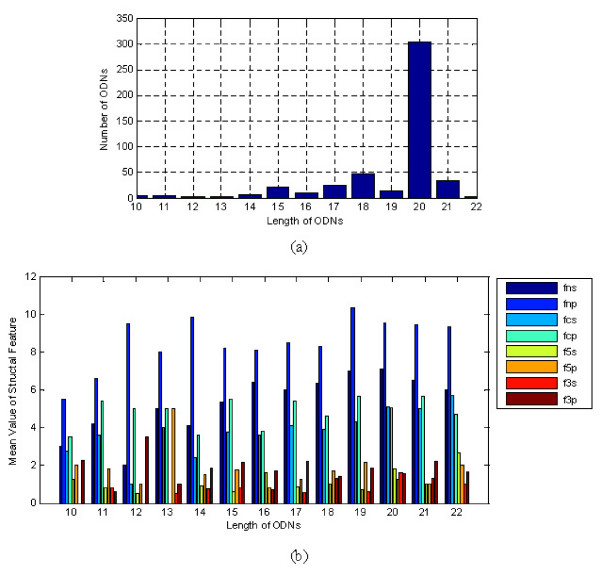
The distribution of ODN length and length-limited features. (a) The distribution of ODN lengths in the dataset; (b) Mean values of some features of ODNs with different lengths.